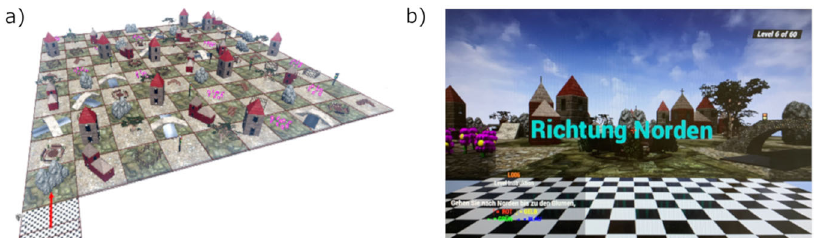
Fig. 8 3D-Navigation Task. a Environment of the Navigation Task. b Perspective from the starting fi eld. Participants began every level from the starting fi eld outside of the environment. They got an instruction in the left corner of the display to the fi rst goal. The cardinal direction of the current level was shown in the middle of the display only for a few seconds at the beginning. The straight direction was always the given cardinal point. As soon as they reached the fi rst goal the direction to the next goal was given in the